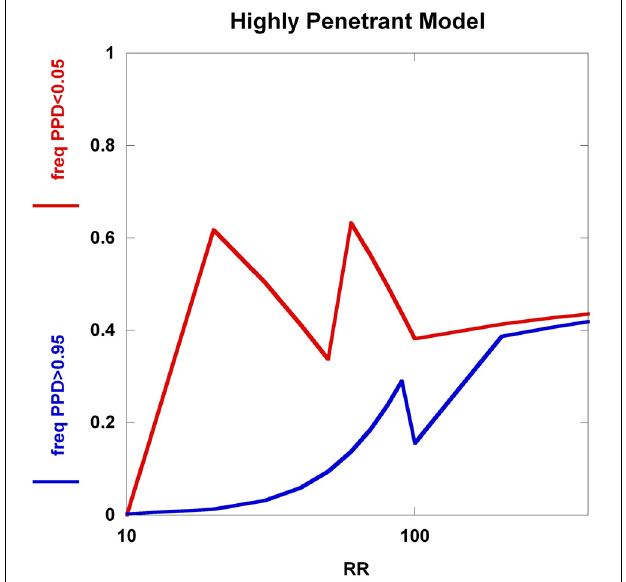
FIGURE 6 | Highly polygenic model. The dynamics of the C 1 /C 2 threshold values under a simplified model is shown as the relative risk of the SNPs varies. The highly polygenic model has 1000 predisposing SNPs each having predisposing genotype frequencies in controls equal to 10% and a prior probability equal to 0.20. The relative risk was varied from 1.02 to 1.80.